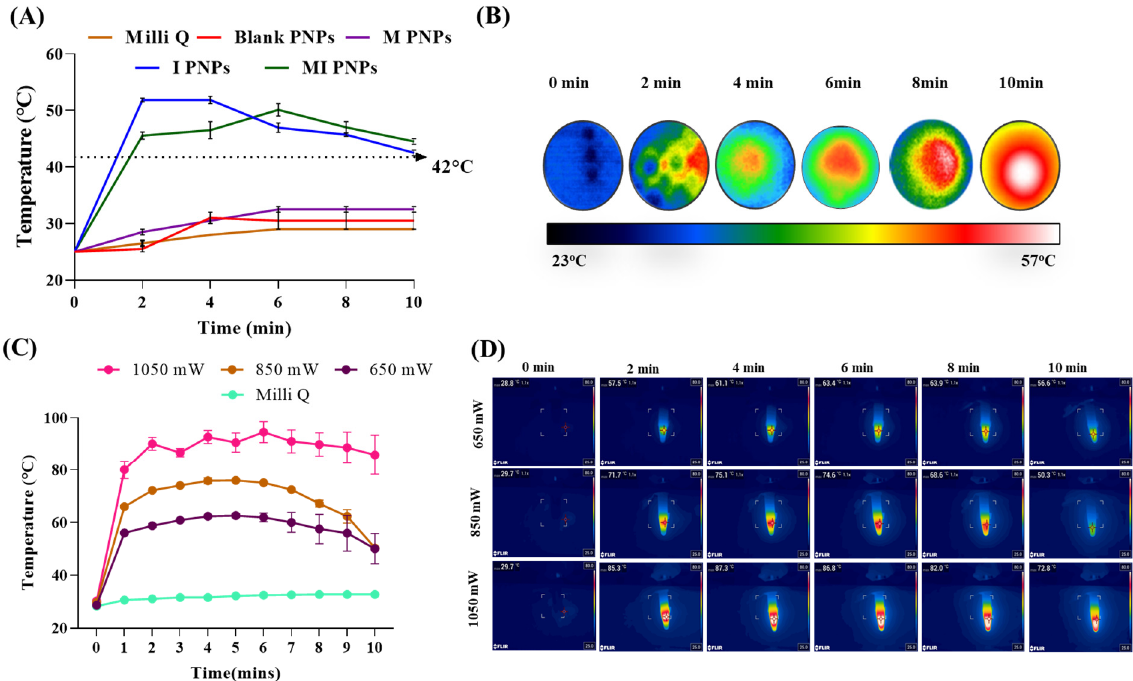
Figure 2. Photothermal transduction efficacy studies of the MI PNPs during exposure to NIR 808 nm light. ( A ) Line graph indicating the temperature profiles of the various PNPs and controls. ( B ) Representative thermal images indicating the temperature increments. ( C ) Line graph indicating the temperature profiles of the various PNPs and controls for different power intensities of the NIR light. ( D ) Representative thermal images indicating the temperature increments for different power intensities of the NIR light.